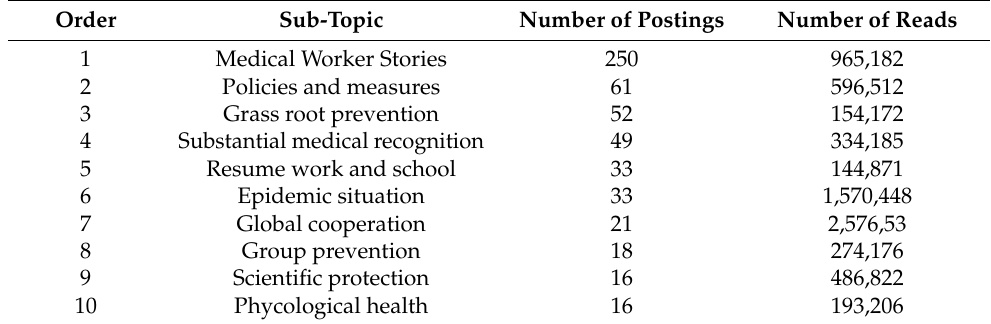
Table 5. Public attention (reads) on different sub-topics of the government at stable stage of COVID-19.